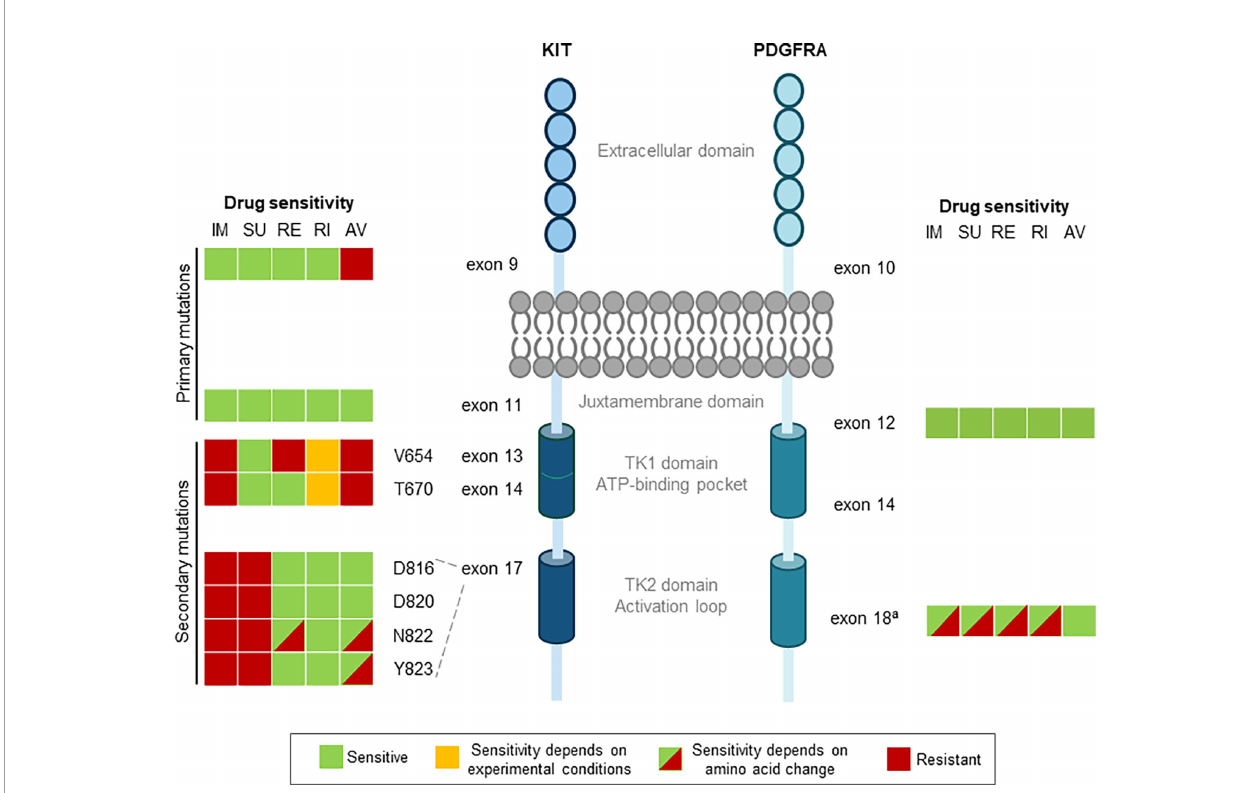
FIGURE 1 | Drug sensitivities for primary and secondary mutations in GIST. Colors denote drug sensitivity: green indicates sensitive, orange indicates sensitivity depends on experimental conditions, red indicates resistant, and red/green hatching indicates that the sensitivity is dependent on the amino acid change. a Approved TKIs are sensitive to non D842V, but only avapritinib and, to some degree, ripretinib are potent against the PDGFRA exon 18 D842V mutation. AV, avapritinib; GIST, gastrointestinal stromal tumors; IM, imatinib; PDGFRA, platelet-derived growth factorreceptor a; RE, regorafenib; RI, ripretinib; SU, sunitinib; TK1, tyrosine kinase domain 1; TK2, tyrosine kinase domain 2.